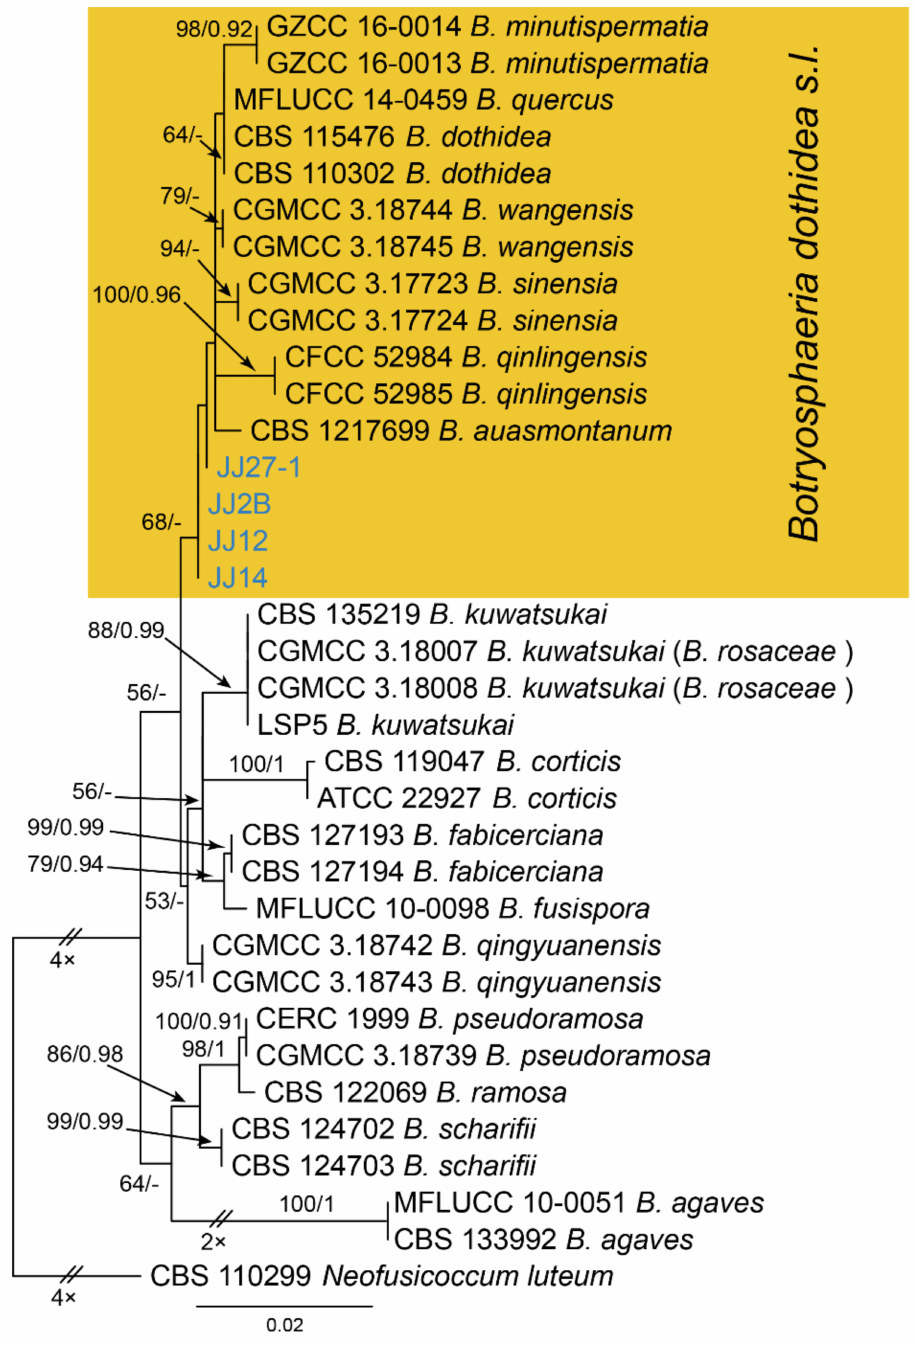
Figure A2. Phylogram generated from RAxML analysis based on combined ITS, tef1 and tub2 sequence data of Botryosphaeria isolates. The tree was rooted to Neofusicoccum luteum (CBS 110229). The scale bar indicates 0.02 nucleotide changes per site. Isolates from this study are marked in blue, and the identified species is marked in